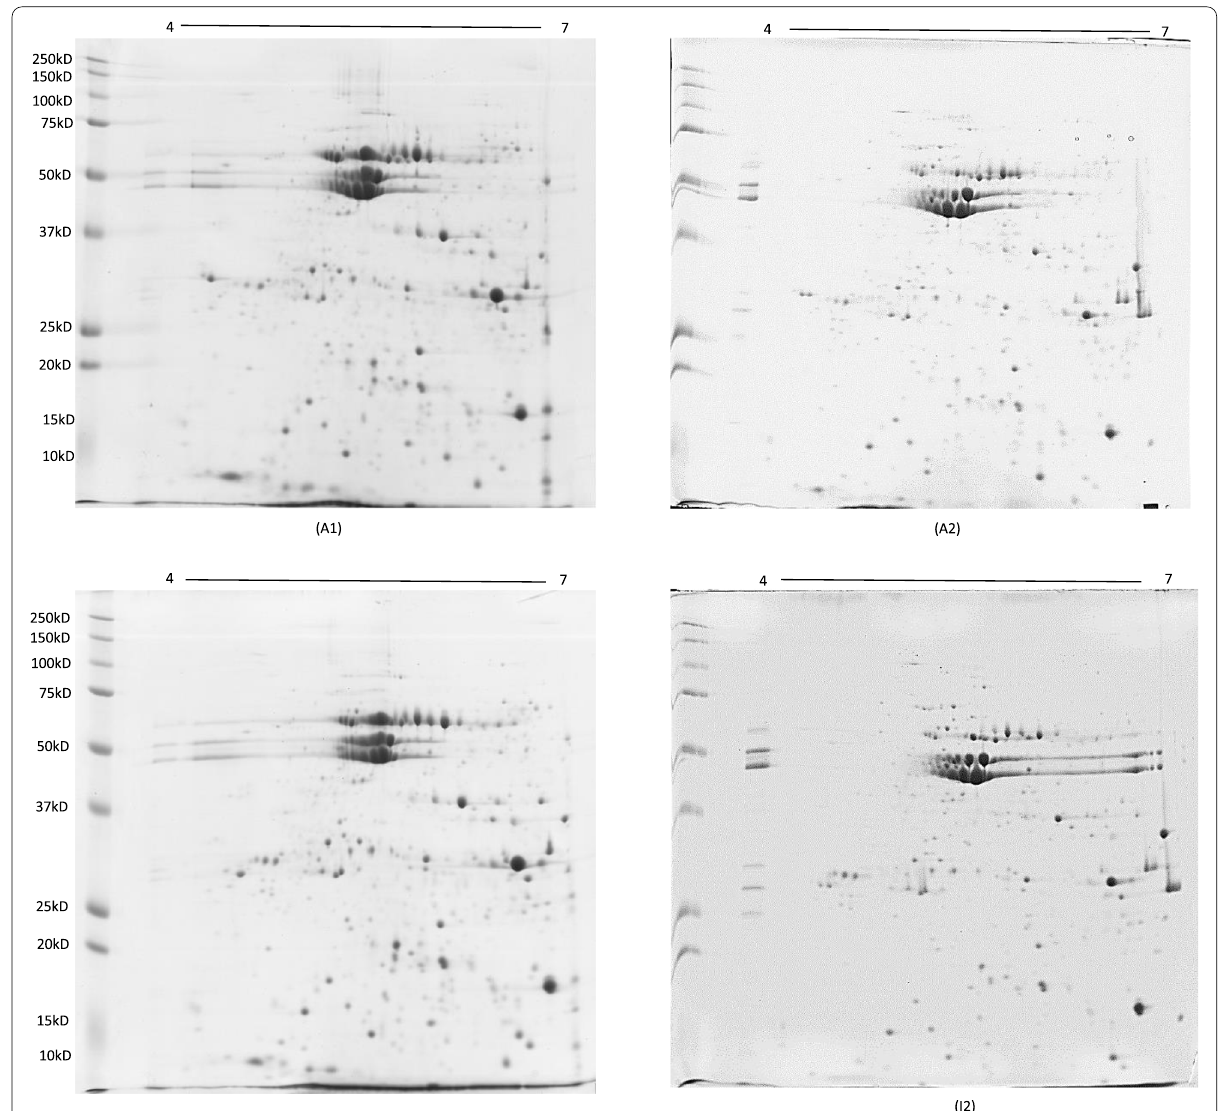
Fig. 2 Comparative maps of protein profile from grains of two Brazilian cowpea ( Vigna unguiculata ) cultivars. (A) BRS Aracê and (I) BRS Itaim. (A1) and (I1) without Clean-up; (A2) and (I2) with Clean-up. 250 μg of proteins were separated using 13 cm linear IEF, pH 4–7 IPG strips for the first dimension and 125 g L − . 1 SDS-PAGE gels for the second dimension. Gels were stained with Coomassie Brilliant Blue